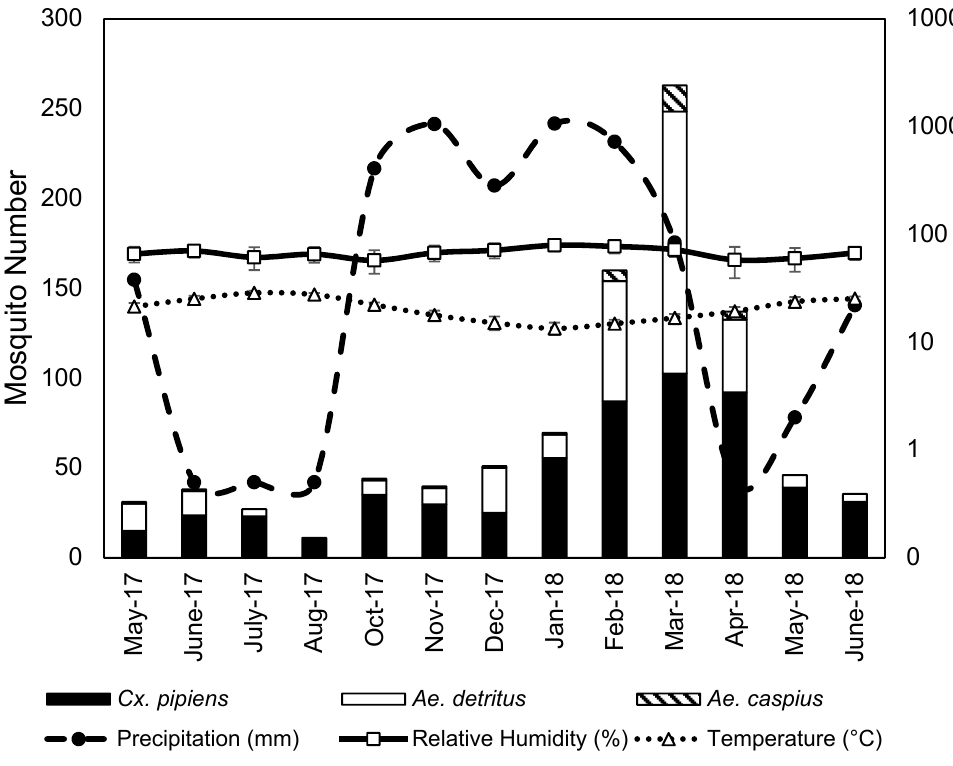
Figure 2. Relationships between weather variables and mosquito seasonal activity. The secondary Y -axis illustrates the values of three weather variables (temperature, relative humidity and precipitation).